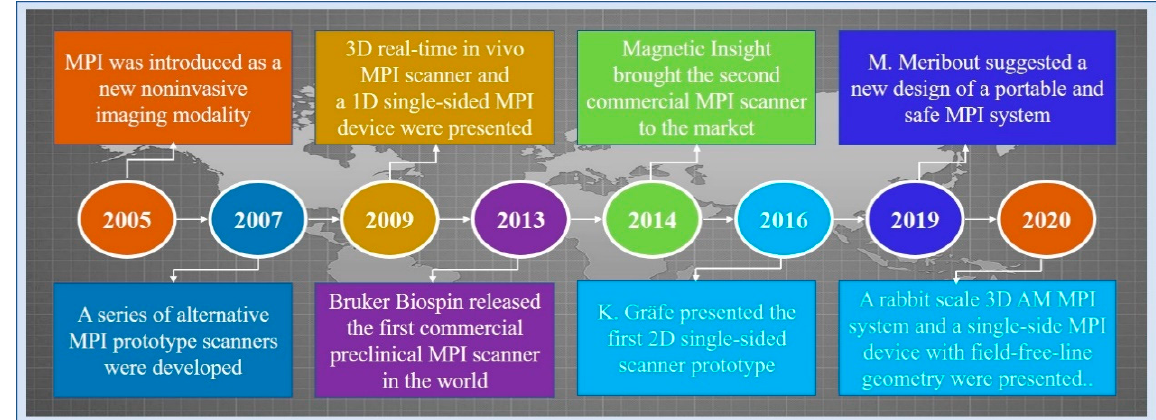
Figure 1. A timeline of MPI history.